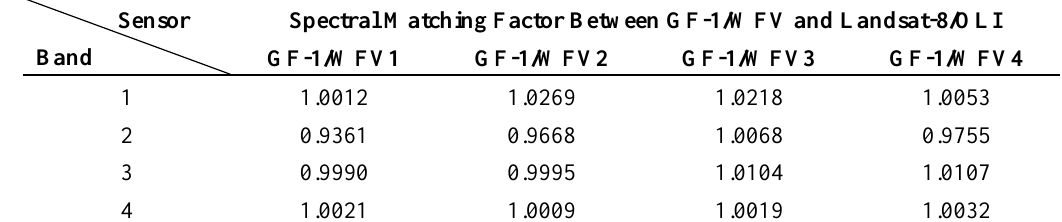
Figure 4. Spectra plot of the calibration site. Table 4. Spectral matching factor between GF-1/WFV and